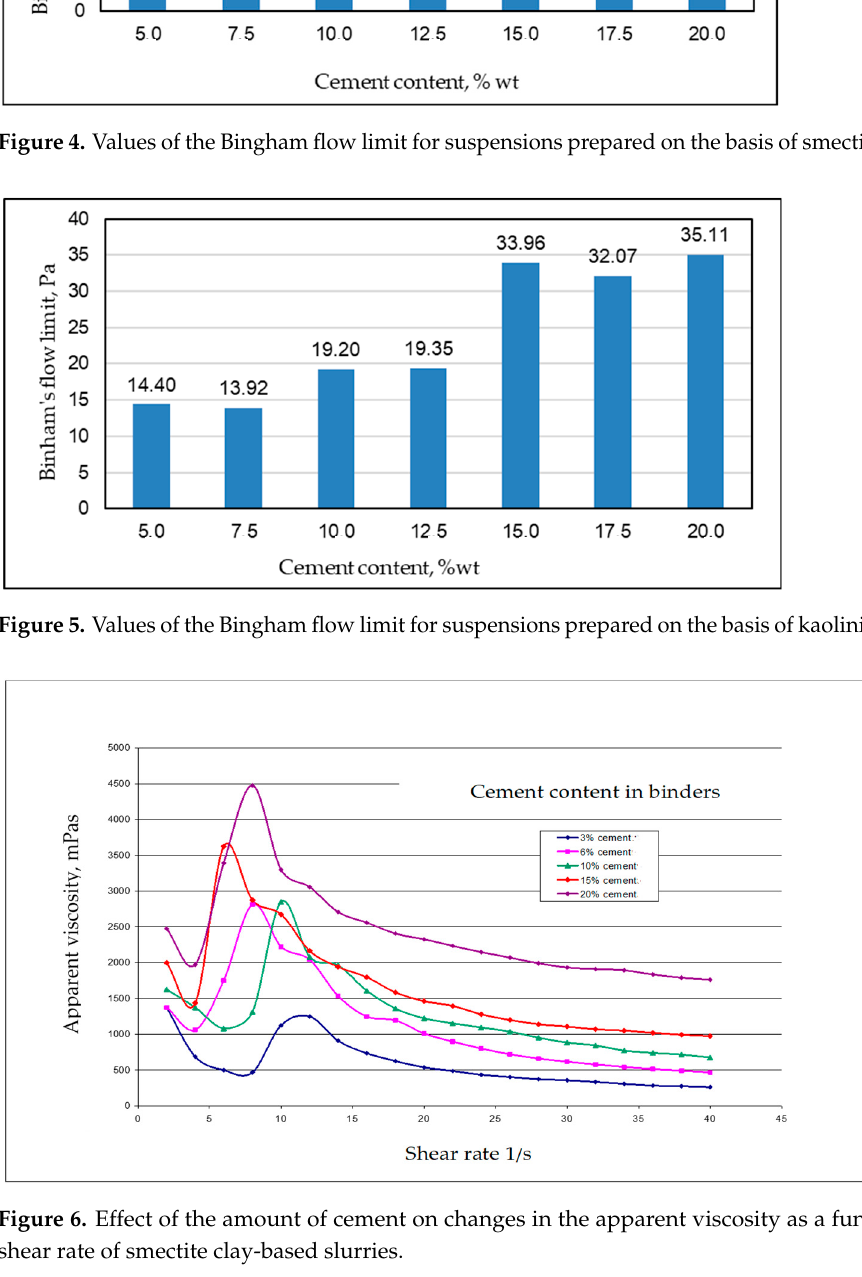
Figure 6. Effect of the amount of cement on changes in the apparent viscosity as a function of the shear rate of smectite clay-based slurries.